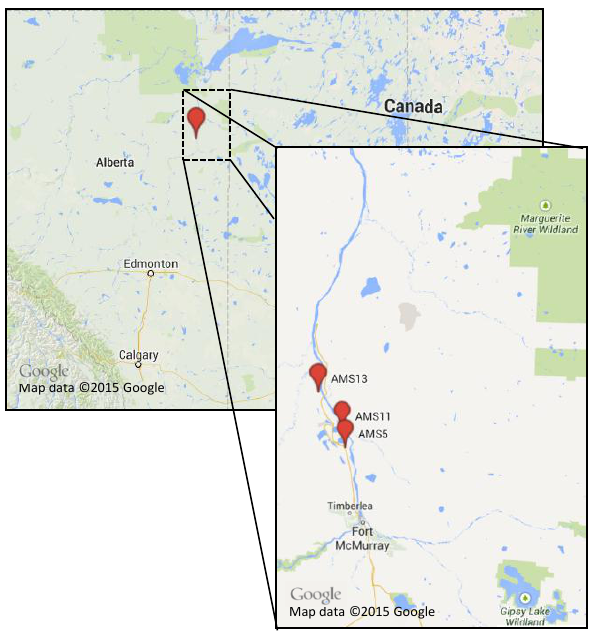
Figure 1. Precipitation and air monitoring sites in the Athabasca oil sands